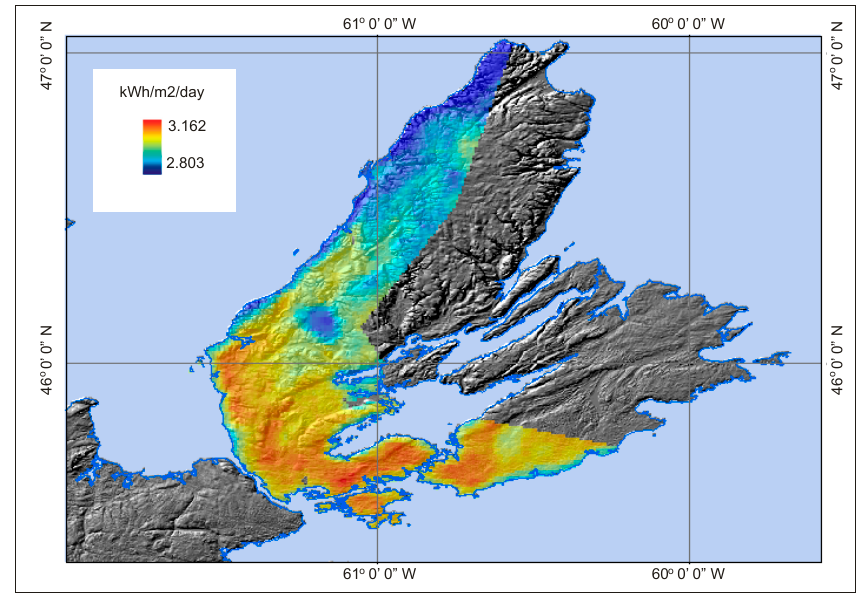
Figure 6. Regional solar map: Strait-Highlands Regional Development Authority.